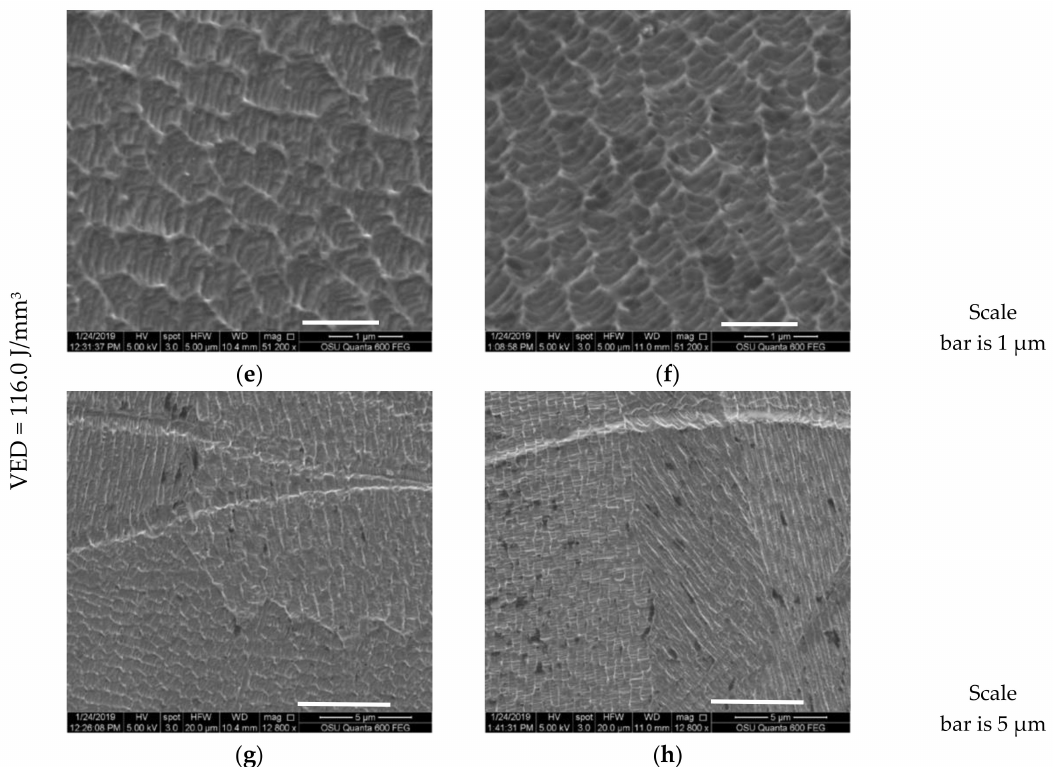
Figure 6. SEM micrographs obtained from ( a , c ) single-mode powder and ( b , d ) bimodal SLM-manufacturedat203W,1000mm / s, VED = 81.2J / mm 3 ; SEMmicrographobtainedfromsingle-mode ( e , g ) and bimodal ( f , h ) SLM-manufactured at 203 W, 700 mm / s, VED = 116.0 J / mm 3